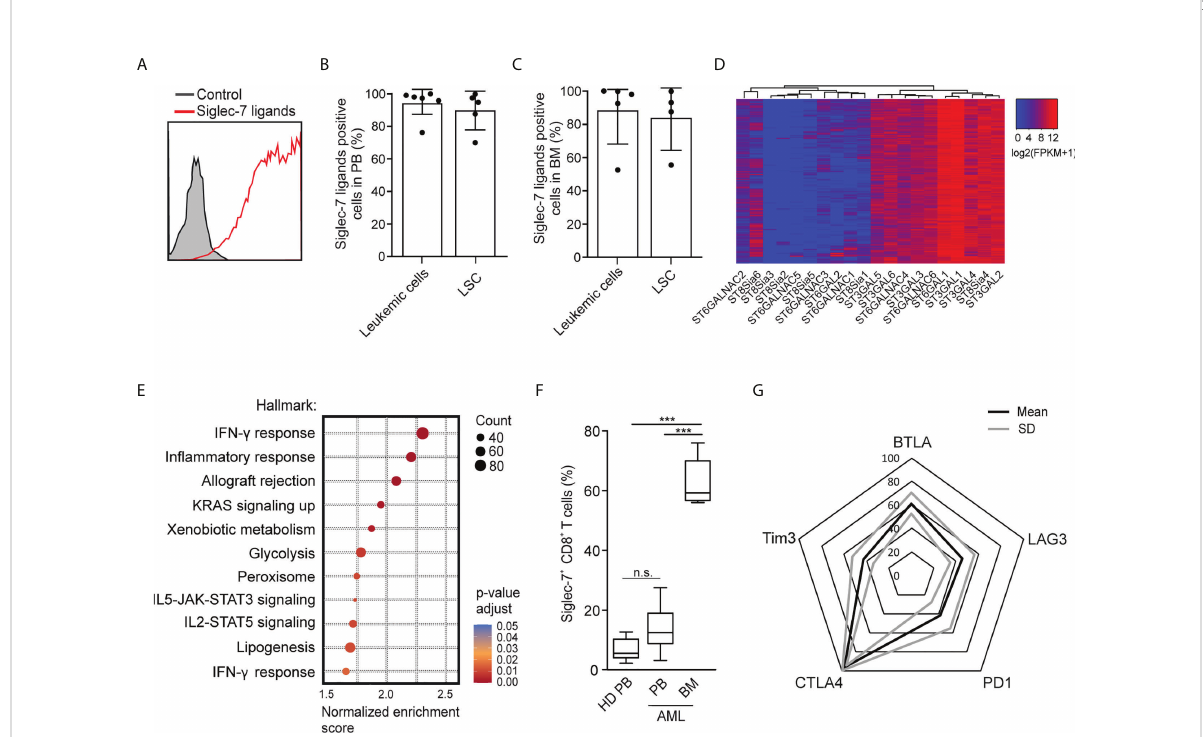
FIGURE 6 Occurrence of Siglec-7 + CD8+ T cells glyco-immune checkpoints in AML. (A) Representative fl ow cytometric histogram demonstrating Siglec-7 ligands surface expression on AML cells isolated from bone marrow (BM). (B – C) Siglec-7 ligands expression on AML patient peripheral blood leukemic cells (n=6) and leukemic stem cells (LSC; n=5) (B) , or bone marrow leukemic cells (n=5) and leukemic stem cell (LSC; n=4) (C) . (D) RNA expression of sialyltransferases in AML patients based on TCGA Network data computed by a dendrogram clustering algorithm and (E) gene set enrichment analysis performed using hallmark gene sets (n=818). (F) Quantitative analysis of Siglec-7 expression by CD8+ T cells from the PB (PB, n=8) and from the bone marrow (BM, n=5) of patients with acute myeloid leukemia (AML). (G) Radar chart of fl ow- cytometric data demonstrating surface coexpression of Siglec-7 with PD1, CTLA4, BTLA, LAG3, or TIM3 on CD8+ T cells from AML bone marrow (n=4). Statistical analyses were performed by one-way ANOVA followed by Bonferroni posttest (F) ***P < 0.001; n.s., not signi fi cant. Error bars,